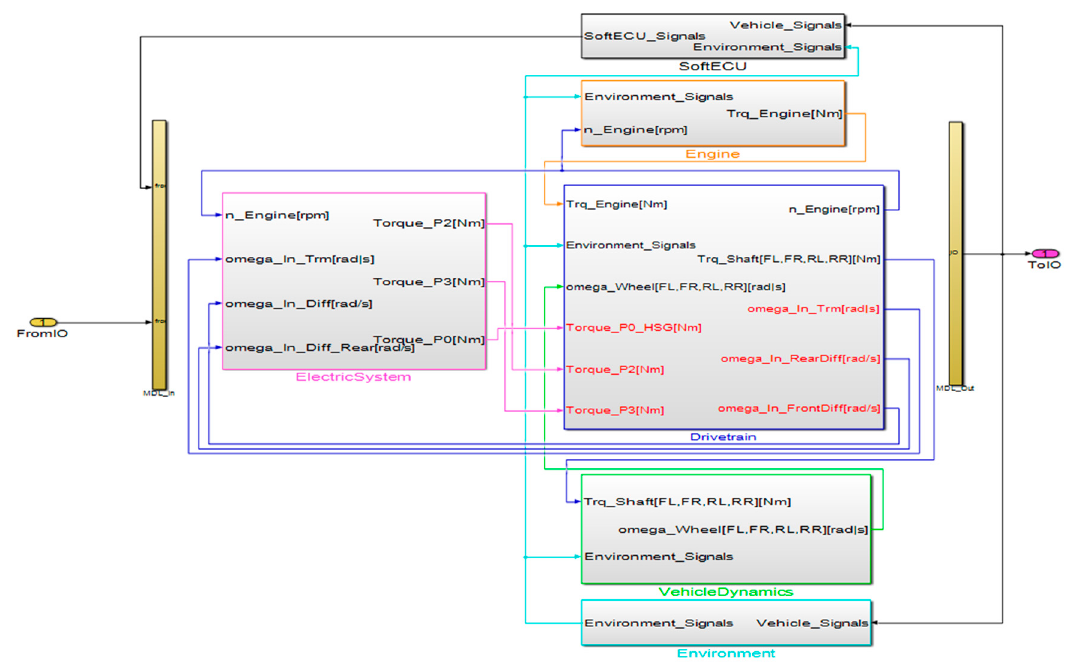
Figure 2. TMED-type HEV simulation model.